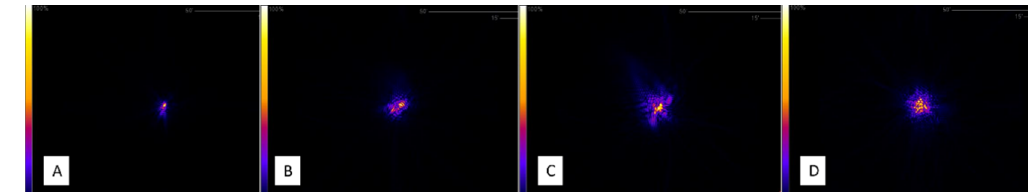
Figure 1. Point Spread Function excluding second-order aberrations (PSFw2) of a sample of patients implanted with different types of intraocular lenses: ( A ) SA60AT, PSFw2 = 0.5303; ( B ) MPLUS 15, PSFw2 = 0.3044; ( C ) MPLUS 30, PSFw2 = 0.2211; ( D ) Precizon, PSFw2 = 0.2195.